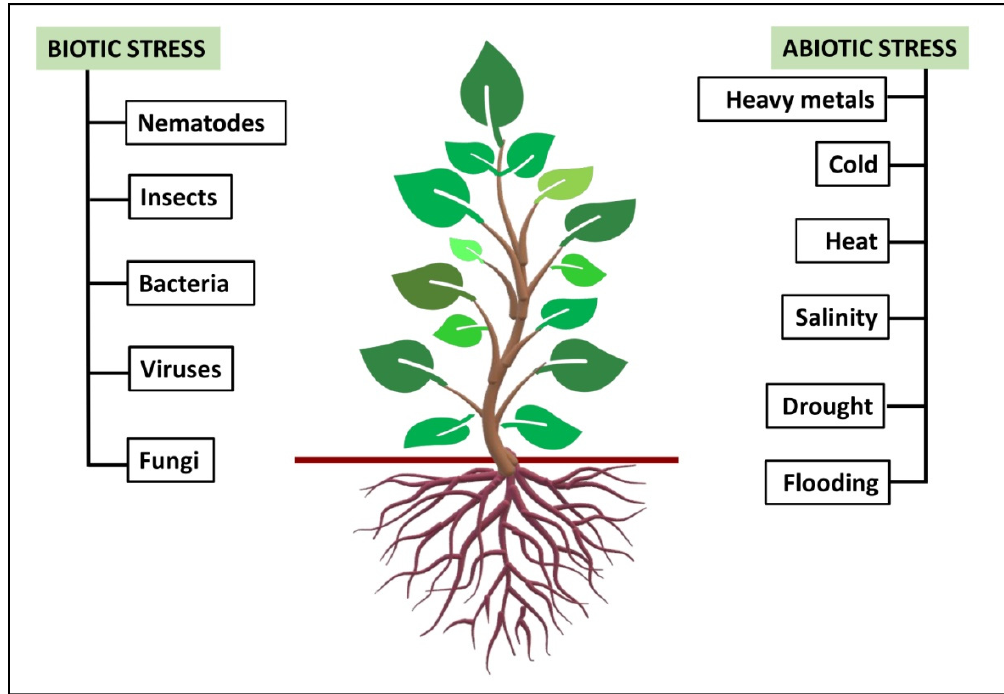
Figure 1. Different types of biotic and abiotic stresses that retard the growth and development of